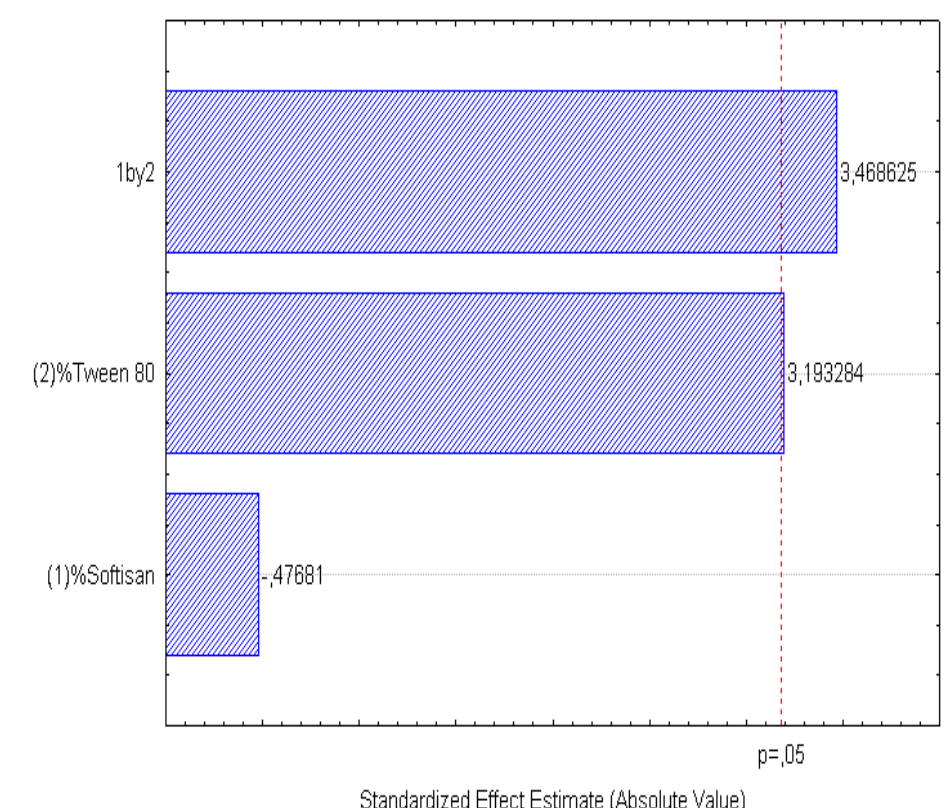
Figure 5. Pareto chart of the analyzed effects for PI.